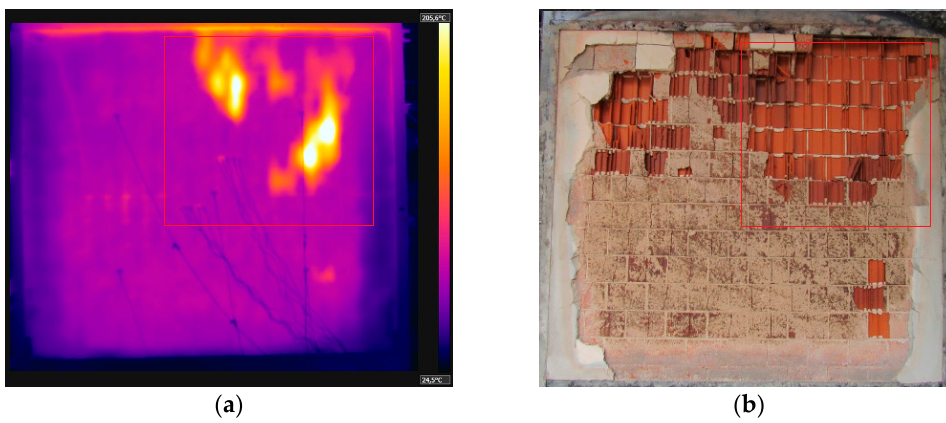
Figure 14. Temperature profile at 240 min—W4.